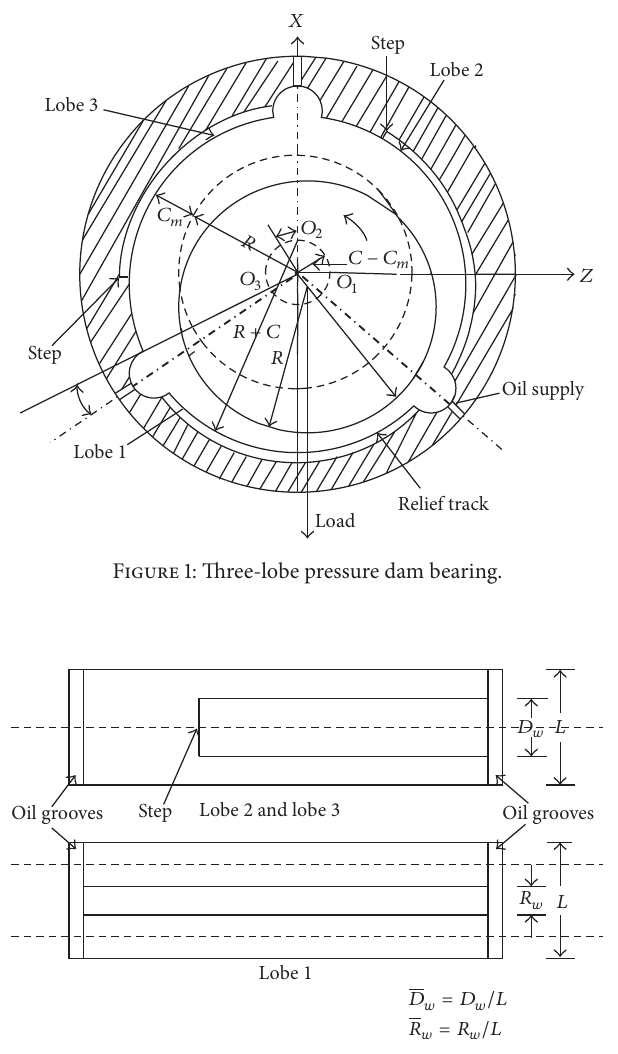
Figure 2: Individual lobes of three-lobe pressure dam bearing.